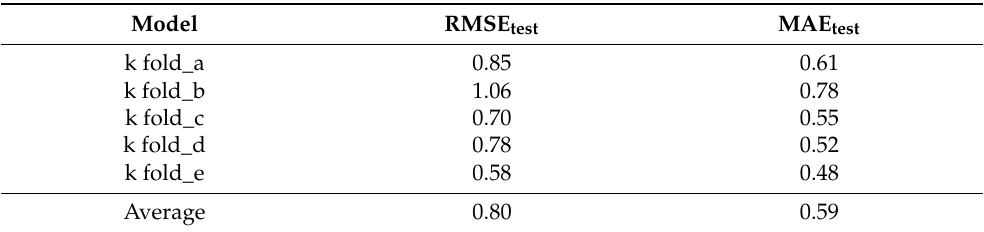
Table 1. Averages of RMSE test and MAE test resulting from five-fold cross-validation of model based on Dataset